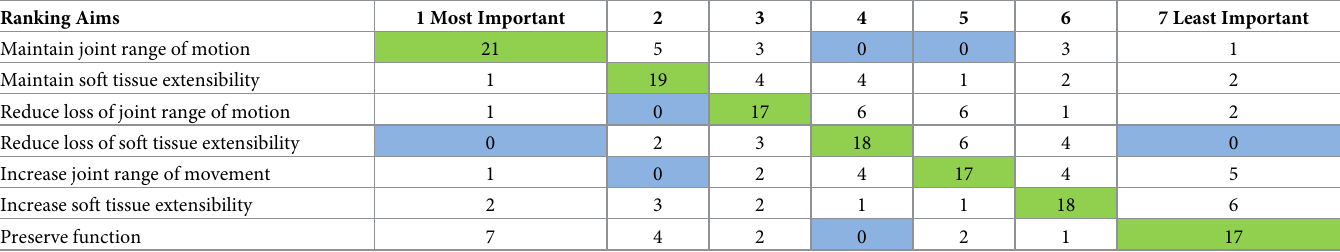
Table 2. Rankings awarded by respondents based on the importance of the aims of passive limb range of motion exercises.